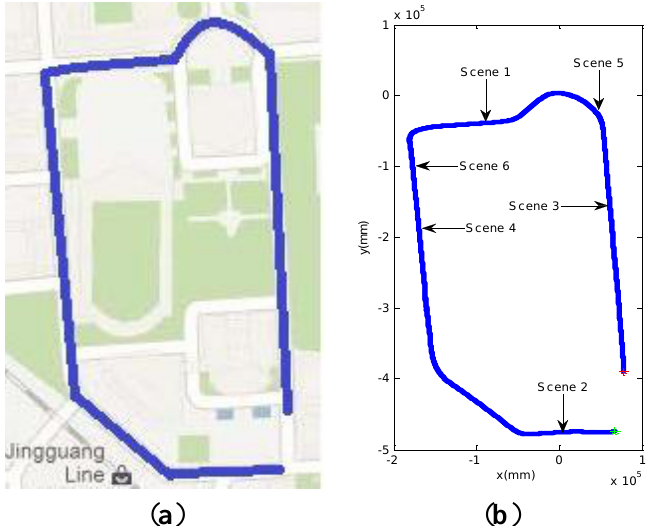
Figure 10. The running route of the vehicle in first experiment. ( a ) The experimental site in the Google map. ( b ) The position of four